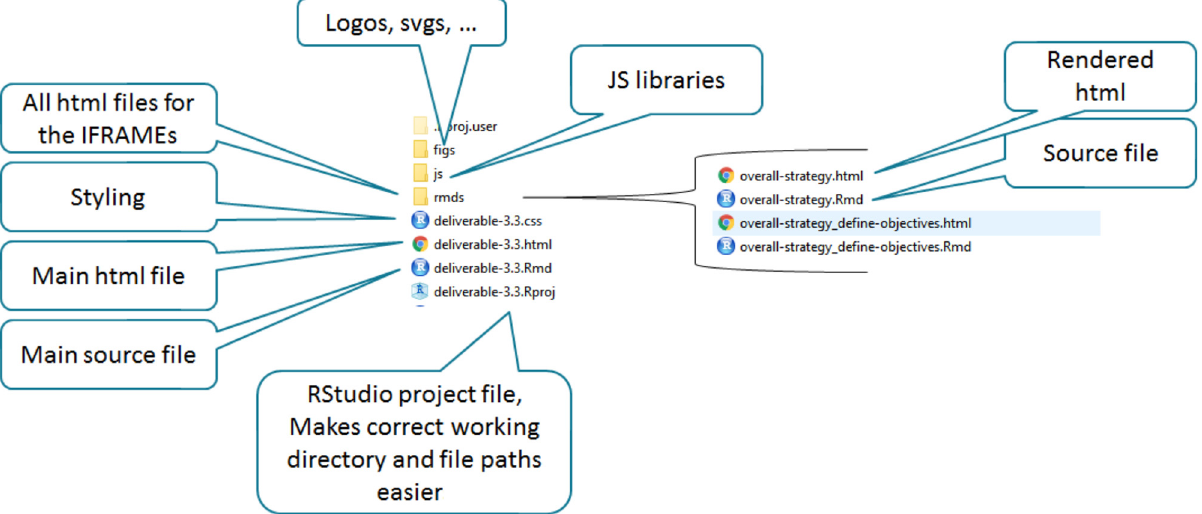
Fig. 5. File structure of the web-based interface.